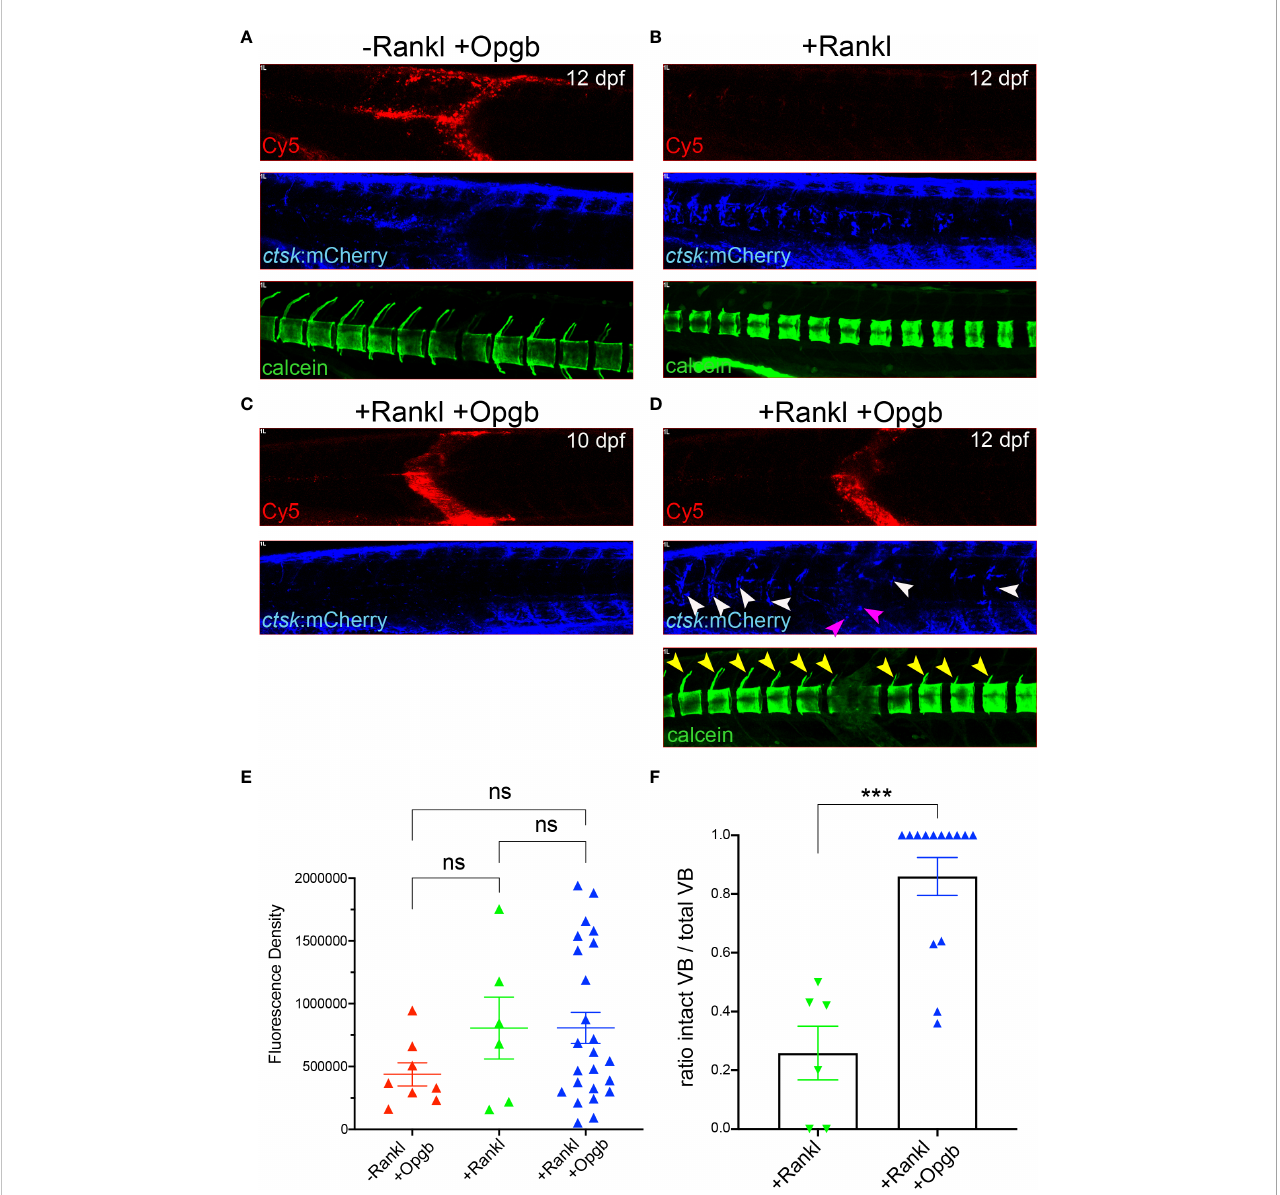
FIGURE 7 Nanoparticle-derived opgb :GFP protectsmineralizedvertebral archesfromresorptionby Rankl-inducedosteoclasts. Cy5-labelledCaPnanoparticlesfunctionalized with mpeg1:opgb- p2a-EGFPplasmidwereinjectedintotrunkmuscleof ctsk :nlGFP/ rankl : HSE: CFPdouble transgeniclarvaeat9dpf andimaged at10 and12dpf. (A) Lateral viewof trunkregion. Intheabsence of Rankl induction, Cy5-labellednanoparticles(top)recruit ctsk :mCherrypositivecellstotheinjectionsiteat 72 hpi (middle).Calceinstainingat 12dpf indicatesnormalmineralization of vertebralarches (bottom,n=4). (B) AfterRankl inductionat9dpf andintheabsenceofCaP nanoparticle injection(top), ctsk :mCherryexpressingosteoclastsformalongvertebralbodies(middle).Calceinstainingindicates complete resorptionof neural vertebral arches(bottom). (C) AfterRanklinductionat 9dpf andinjection of mpeg1:opgb- p2a-EGFP-functionalizednanoparticles at1hourafterRanklinduction, no ctsk :mCherry cellsarerecruitedat10dpf (i.e.,24 hpi). (D) Samelarva asinCat 72 hpishowingformationof Rankl-inducedectopic ctsk :mCherry osteoclasts. Calcein stainingindicatesthatdespiteabundantosteoclasts, mineralizationofvertebral neural archesispreserved(n=14 larvae). (E) Statisticalanalysisof relative fl uorescence densityof mCherrysignalat12 dpfwithinspeci fi edregionof interest atinjectionarea, i.e. vertebralbodies(VBs)8-10, indicative forrecruitmentof ctsk positivecells. (F) Statisticalanalysisofthe ratioof calcein-stainedVBs withneuralarches present overtotal numberofVBs.Only VBswith ctsk positiveosteoclastspresent after Rankl inductionwere counted. ***, p<0.005;ns,notsigni fi